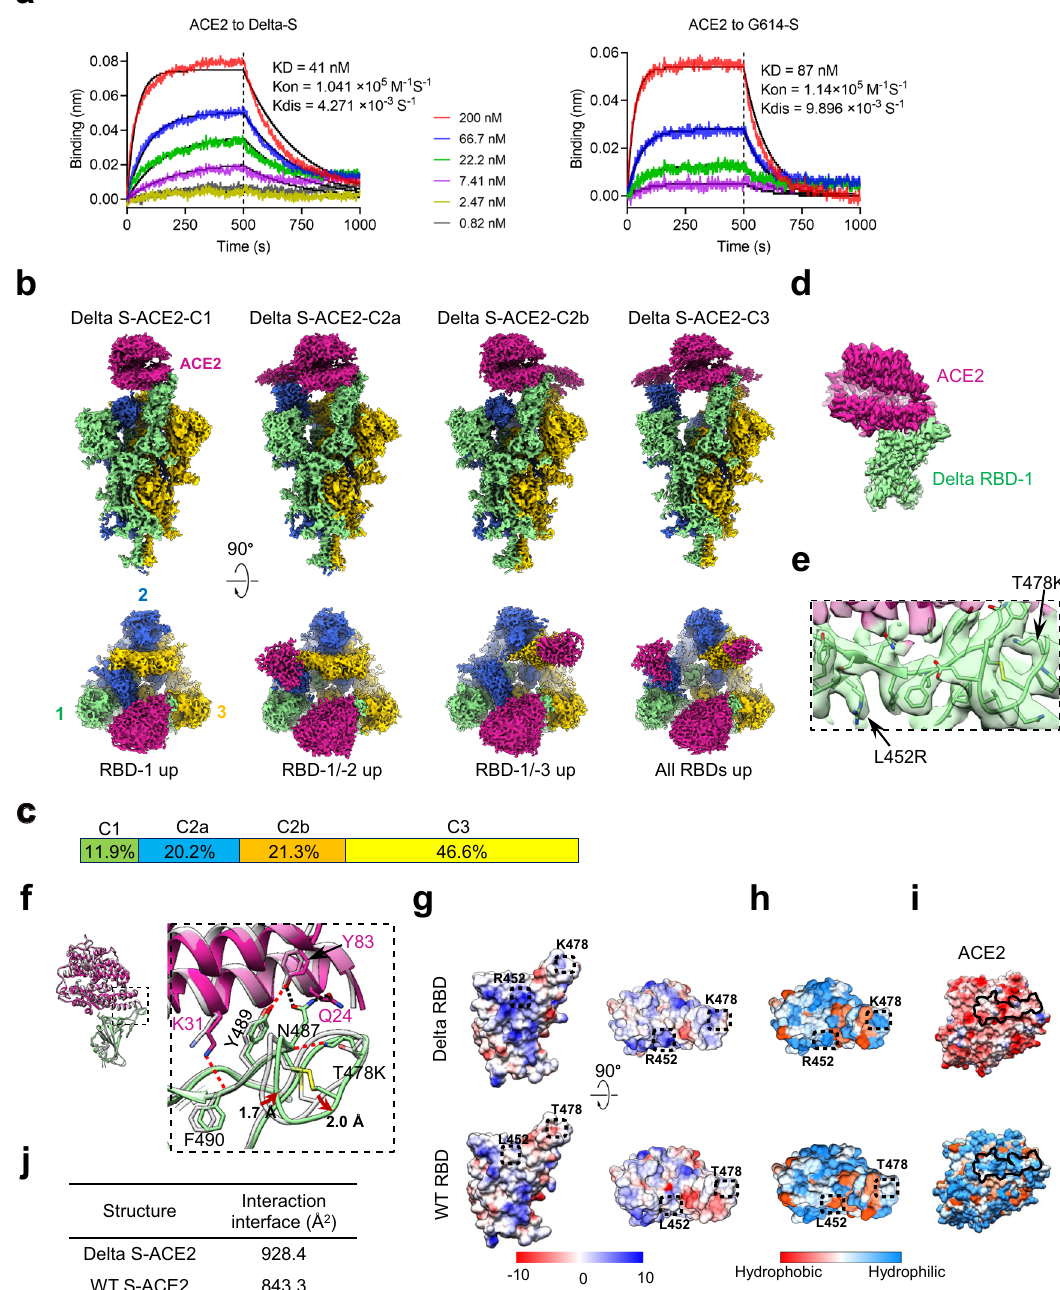
Fig. 2 Structural basis of enhanced Delta variant S trimer/ACE2 interaction. a Measurement of the binding af fi nity between ACE2 and the S trimer of the Delta (left) or G614 (right) variants using bio-layer interferometry (BLI). Association and dissociation steps were divided by dotted lines. ACE2 concentrations tested were shown. Raw sensor grams and fi tting curves were shown in color and black, respectively. Source data are provided as a Source Data fi le. b Cryo-EM maps of the Delta S-ACE2 complex in four distinct conformational states. ACE2 is shown in violet red. This color scheme is followed throughout. c Population distribution of the Delta S-ACE2 conformers. d Density map of the focus-re fi ned Delta RBD-1-ACE2. e Zoomed-in view of the S-ACE2 interaction interface, showing the side chain densities of the substituted L452R and T478K were well resolved. f The substituted K478 forms a new H-bond with N487, resulting in the formation of two new H-bonds with ACE2 (red dotted line), and a conformational change of loop 473 – 490 (indicated by red arrow) relative to that in WT RBD-ACE2 (PDB 6M0J). g , h The electrostatic surface property g and hydrophilicity and hydrophobicity properties h of the Delta and WT RBDs, with the mutated residues indicated. i Similar surface properties for ACE2, with residues in proximity to Delta RBD-1 (< 4 Å) indicated. j Interaction interface areas between ACE2 and RBD of Delta or WT (PDB 6M0J) strain analyzed using